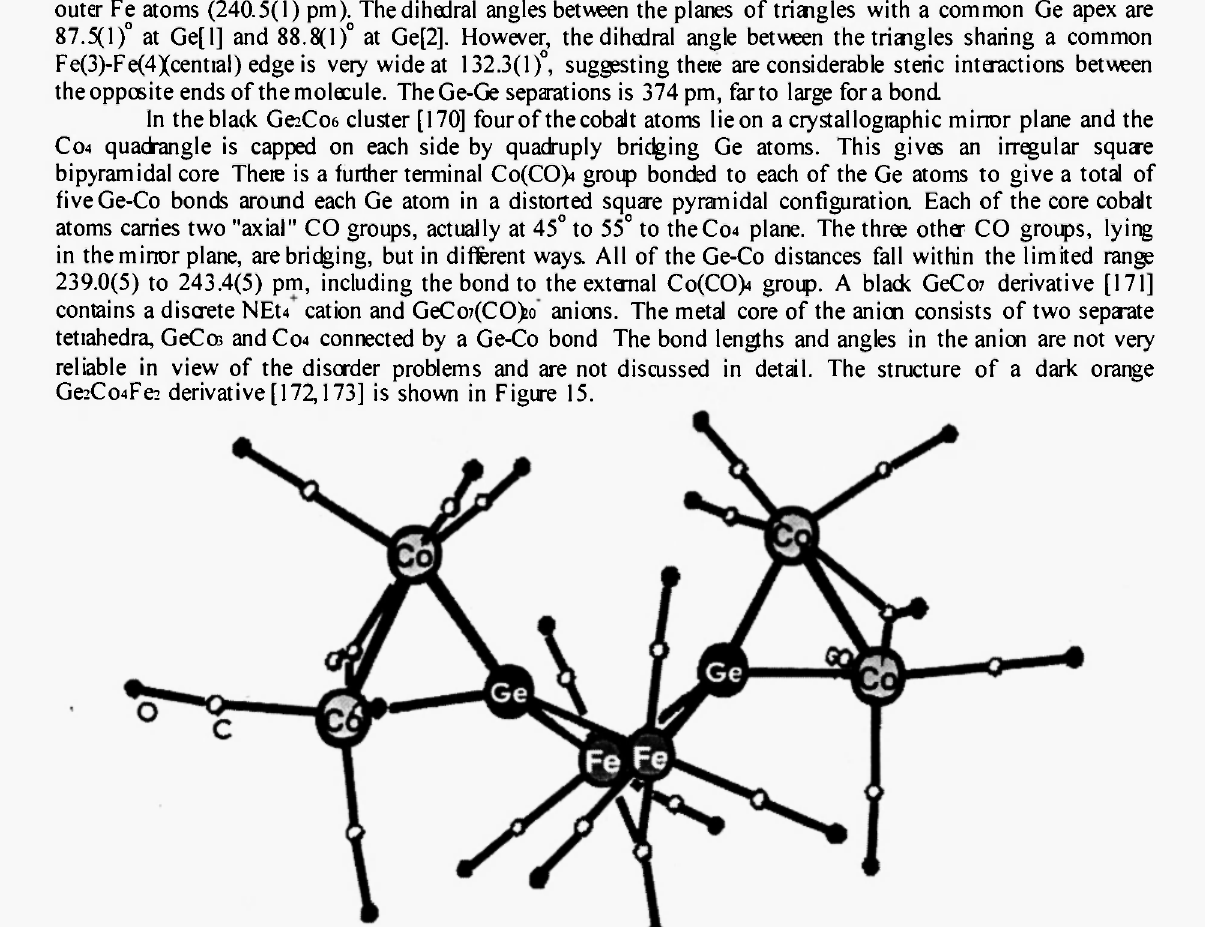
Fig. 15. Structure of Ge2Fe2Co4(CO>: